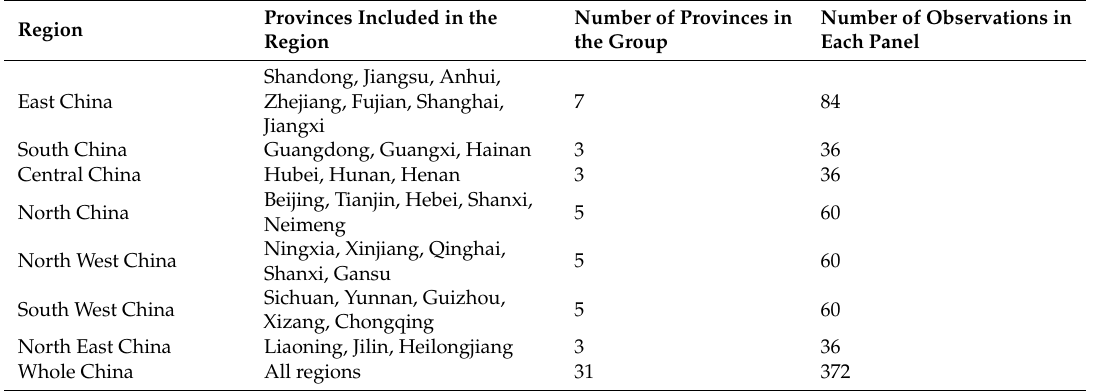
Table 1. The seven major regions in